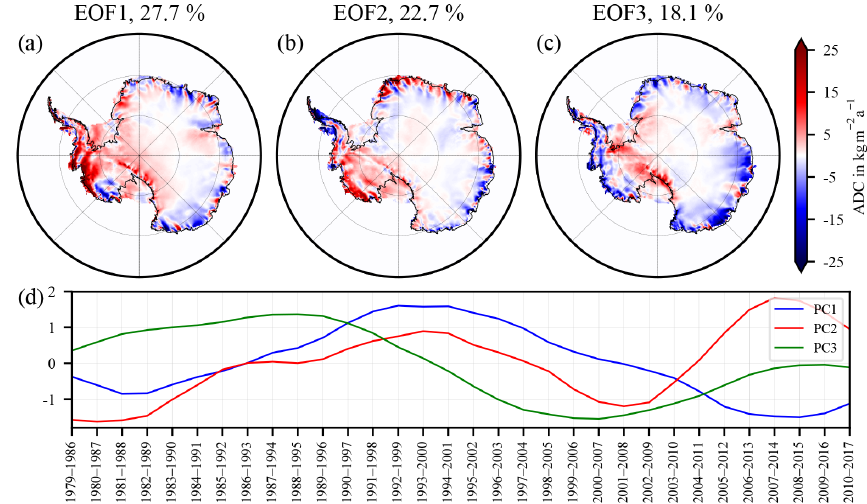
Figure 4. (a) – (c) Area density change (ADC) of the first three EOFs of the trend differences between RACMO2.3p2 and MAR cumulated surface mass balance anomalies (cSMBA). (d) The respective principal components